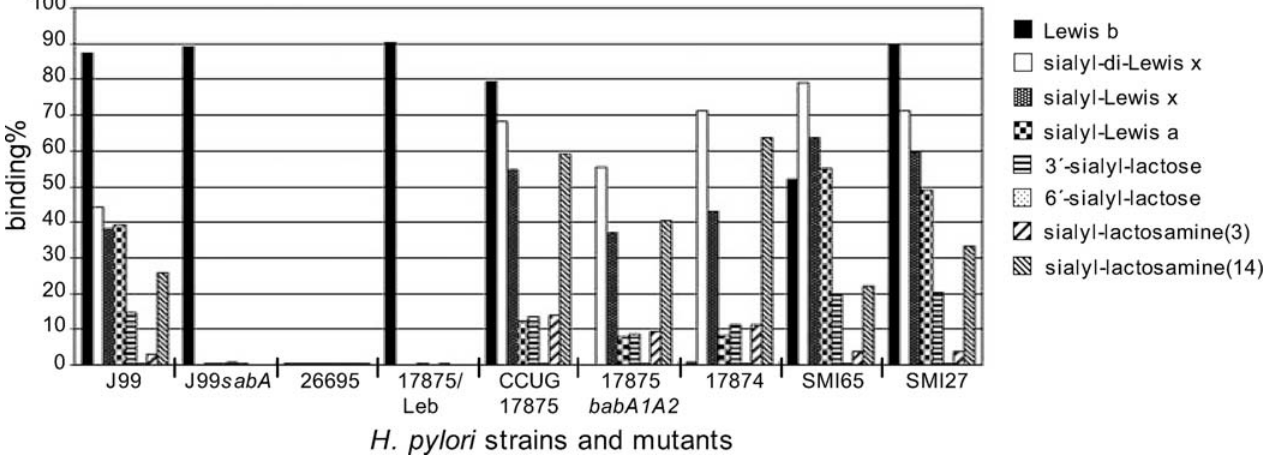
Figure 3. Binding of H. pylori Strains and Clinical Isolates to Fucosylated and Sialylated Glycans of Various Complexities H. pylori reference strains, mutants, and clinical isolates were tested for binding to the fucosylated Leb antigen and to a series of sialylated antigens, all presented by 125 I-labeled albumin conjugates. The y axis gives the percentage of bound conjugate. DOI: 10.1371/journal.ppat.0020110.g003